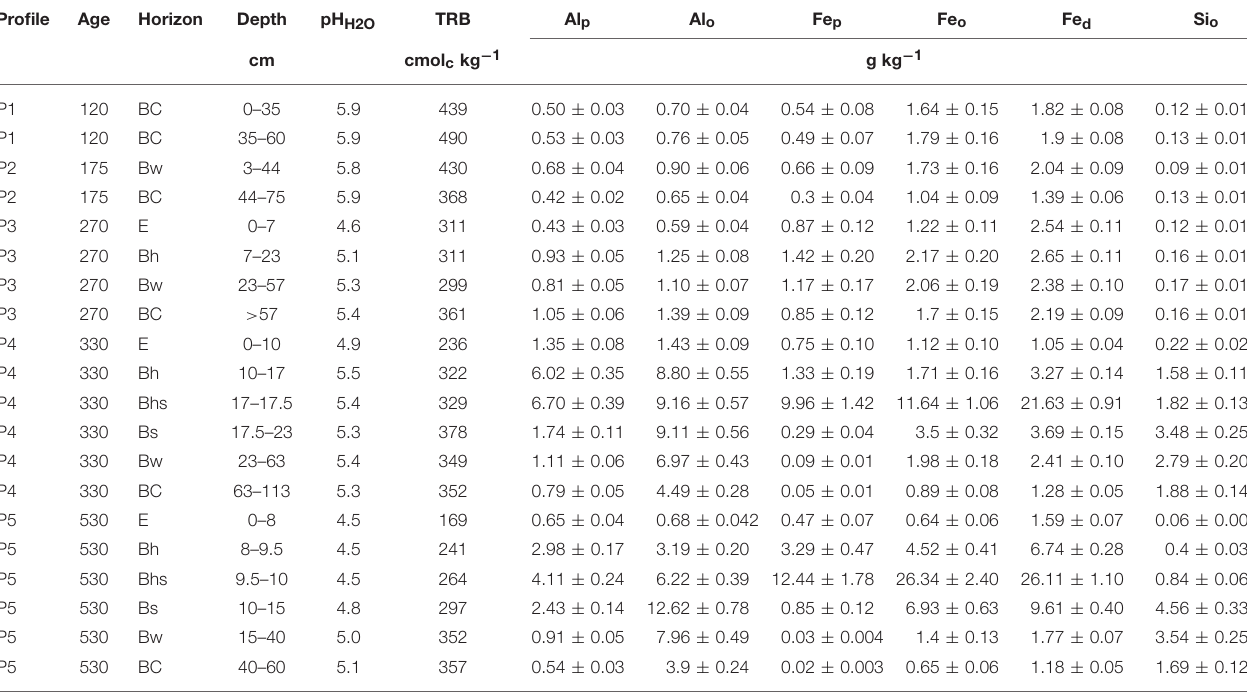
TABLE 1 | Soil physico-chemical properties: pH water , Total Reserve in Bases (TRB), pyrophosphate (p), oxalate (o), DCB (d)-extractable Al, Fe, and Si (values are given ± one standard deviation).